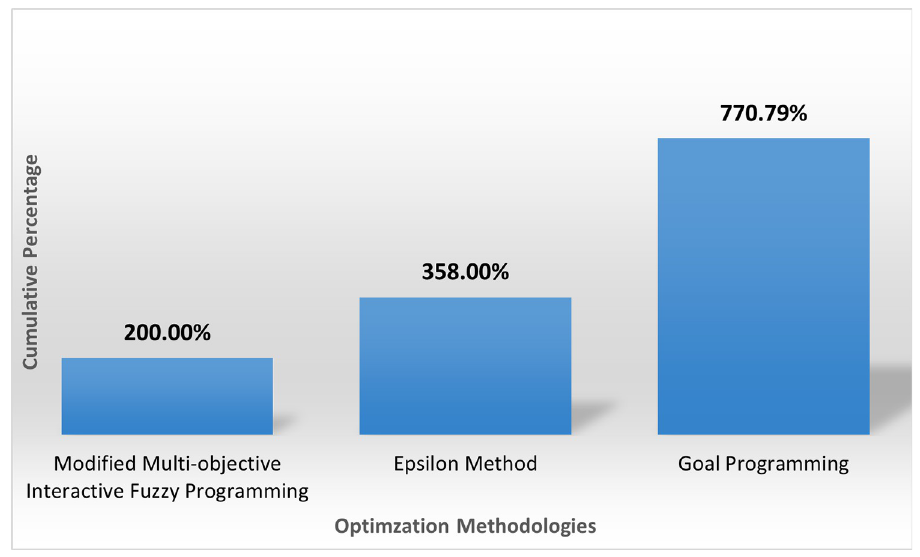
Fig 4. Cumulative gaps of different optimization